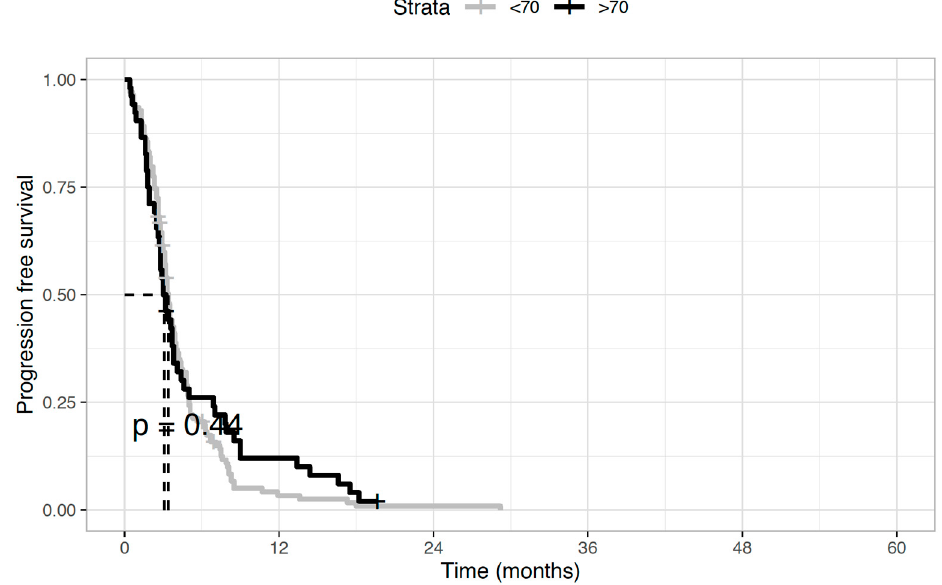
Figure 2. Progression-free survival (PFS) of biliary tract cancer patients receiving second-line chemotherapy. Median PFS was 4.7 months in elderly patients and 4.8 months in younger patients (Hazard Ratio 0.88; p = 0.44).